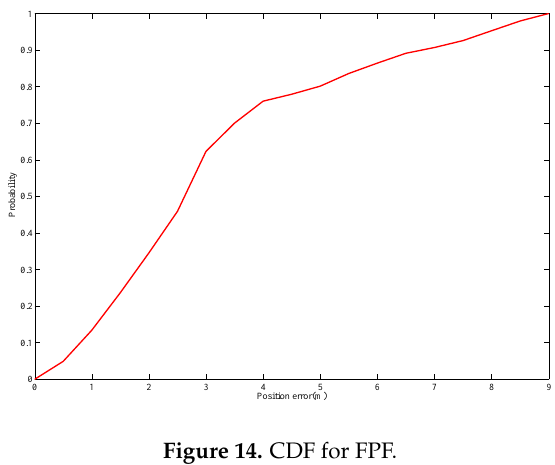
Figure 14. CDF for